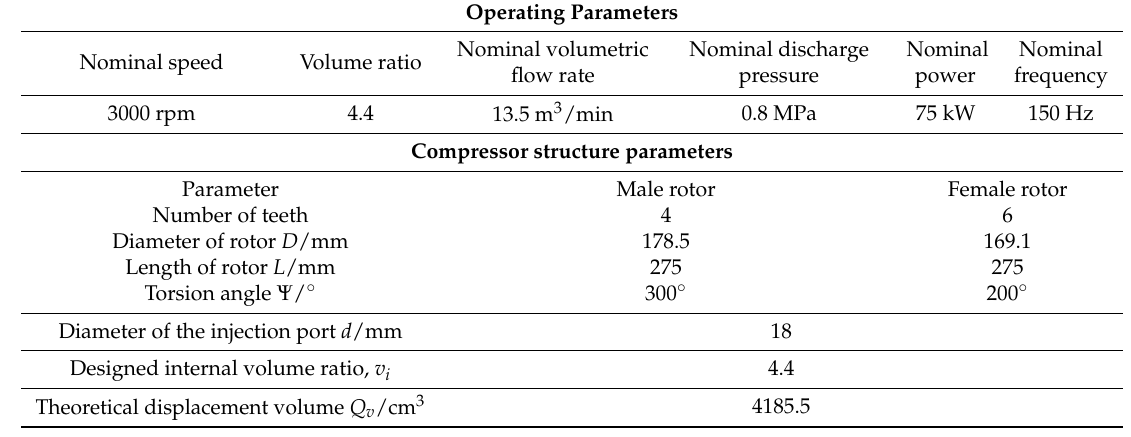
Table 1. Main parameters of the TRL135 twin-screw air compressor.